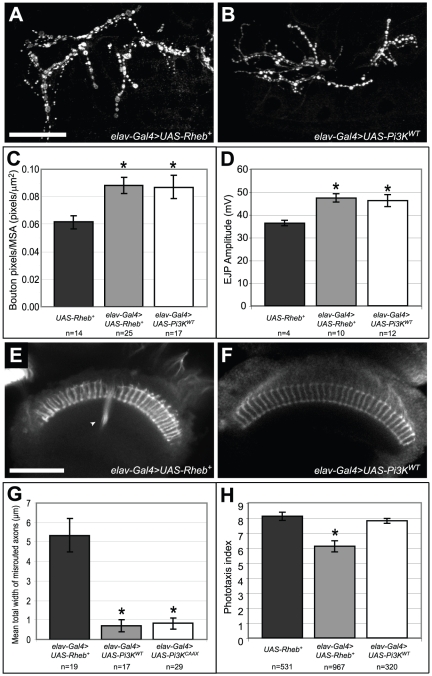
Pi3K and Rheb have similar effects on synapse size and function, but not on axon guidance or phototaxis behavior.(A–C) Neuronal expression of either Pi3K or Rheb had equivalent effects on synapse size, as measured by anti-CSP staining. (D) Suprathreshold electrical stimulation of the motoneuron produces synaptic transmission and depolarization of the underlying muscle known as an excitatory junctional potential (EJP) [33]. This physiological measurement provides a reproducible readout of synapse functionality. Compared to control animals lacking a neuron-specific Gal4 driver, Pi3K expression and Rheb expression both caused similar increases in EJP amplitudes at the neuromuscular junction. (E–G) Anti-Chaoptin staining of photoreceptor axons revealed that, contrary to the axon guidance defects observed in animals overexpressing Rheb (arrowhead), axon guidance misroutings in Pi3K-expressing animals were extremely rare, even when we expressed the constitutively-activated transgene UAS-Pi3KCAAX. (H) Neuronal overexpression of Pi3K did not cause deficits in phototaxis behavior, unlike what was observed when flies overexpressed Rheb. Asterisks denote p<0.05 compared to control UAS-Rheb+/+ animals using a two-tailed student's t-test statistic. Scale bars are 50 microns.